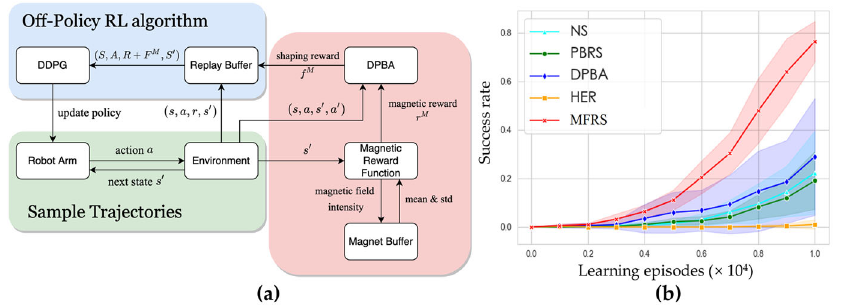
Figure 6. A reinforcement learning method using magnetic-field-based reward shaping (MFRS) for robotic arm control. ( a ) Overview of MFRS for goal-conditioned RL tasks with multiple targets and obstacles. ( b ) Success rate per learning episode of MFRS with comparison to baselines trained in simulation environments. NS: training the policy with the original reward given by the environment without shaping. PBRS [49]: potential-based reward shaping, which adds a calculated shaping reward to the original reward, where the potential function is built on Euclidean distance. DPBA [52]: dynamic potential-based advice, which can transform any given reward function into the form of potential-based reward shaping to ensure the optimal policy invariance property. HER [54]: hindsight experience replay, which relabels the desired goals in the replay buffer with the achieved goals in the same trajectories. We adopt the default “final” strategy in HER that chooses the additional goals corresponding to the final state of the environment.